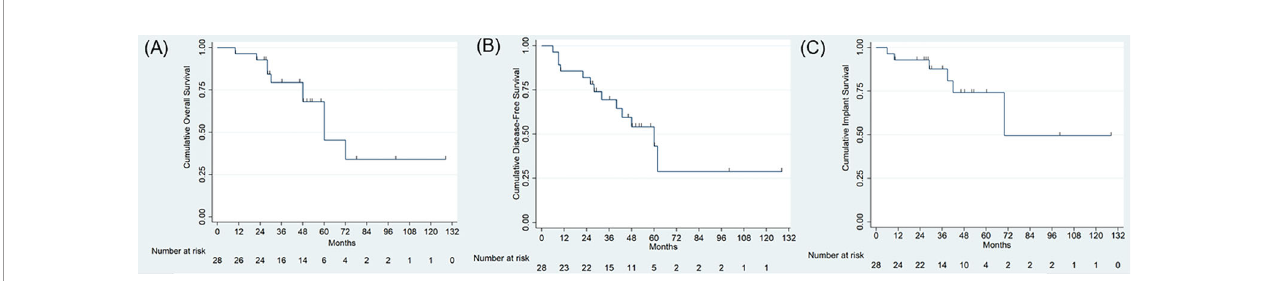
FIGURE 5 | (A, B) Survival analysis using Kaplan-Meier curve showing the cumulative overall survival (A) , and disease-free survival (B) and implant survival (C) for all